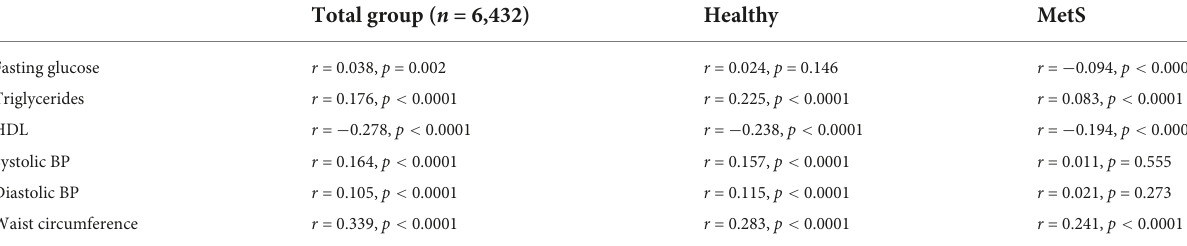
TABLE 2 Pearson’s correlations with uric acid (UA) levels using an unweighted